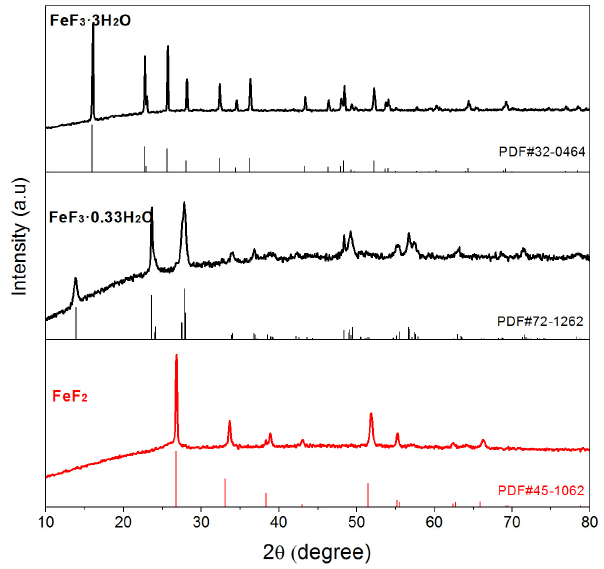
Figure 1. XRD patterns and the standard patterns of the FeF 3 ∙ 3H 2 O precursor, the intermediate prod- uct FeF 3 ∙ 0.33H 2 O and FeF 2 sample. product FeF 3 · 0.33H 2 O and FeF 2